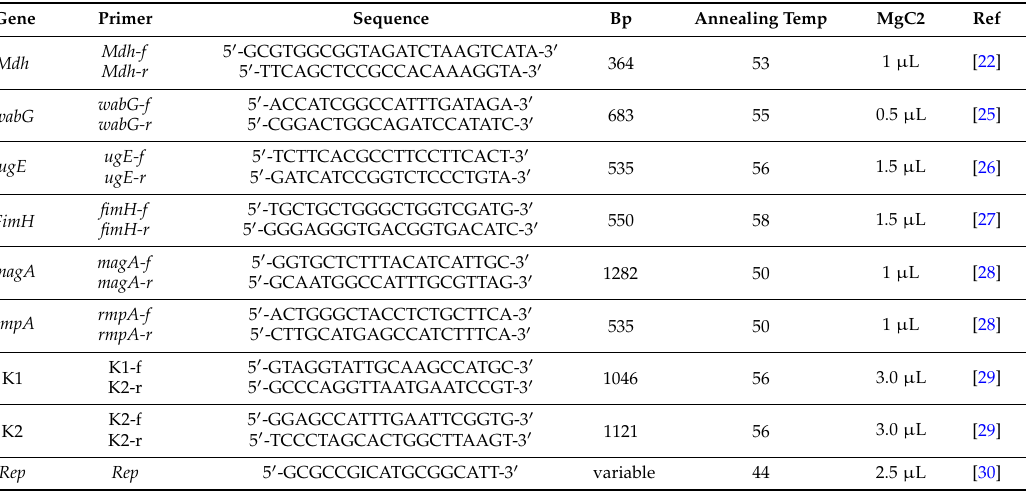
Table 1. List of primers utilized in this